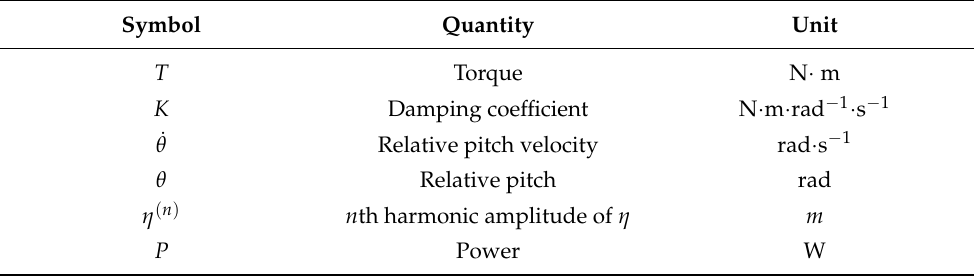
Table 2. Symbols and units. Relative pitch, relative pitch velocity and torque are measured by the encoder and the torque transducer on the hinge axis of